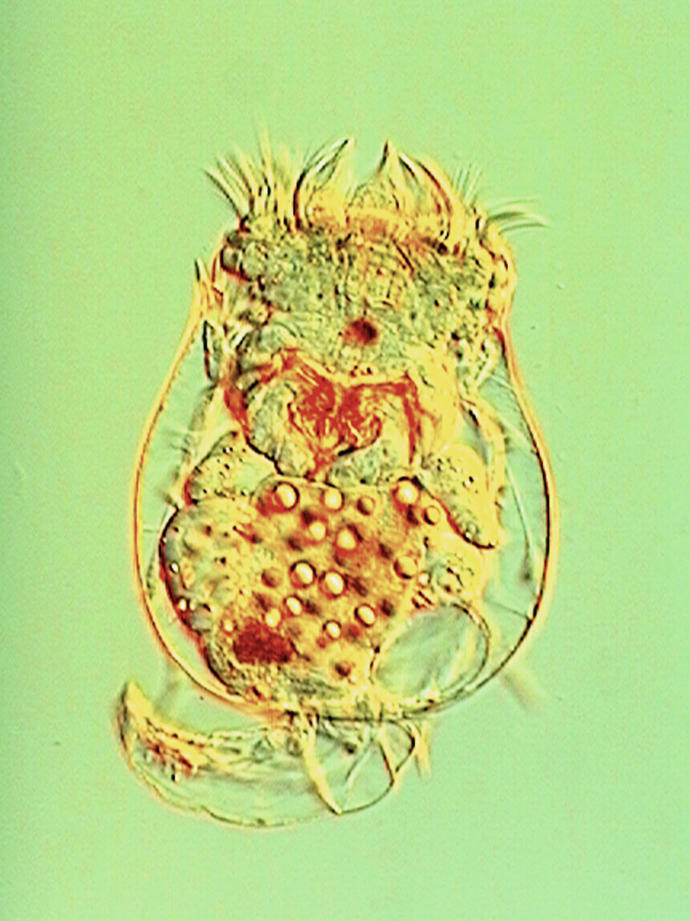
Cryptic cycling: the rotifer Brachionus exhibits regular cycles in abundance, but the alga Chlorella, on which it feeds, does not—except in its genotype frequencies. The same occurs between the phage T4 and bacteria.(Photomicrograph by T. Yoshida and R. Wayne)